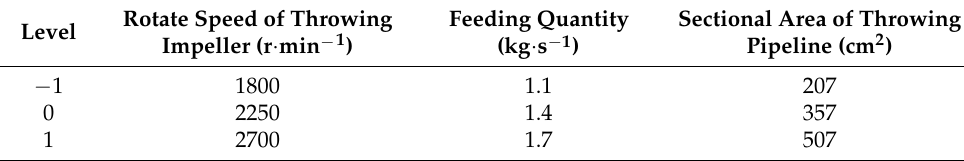
Table 1. Factors and levels of orthogonal rotational quadratic combination test.